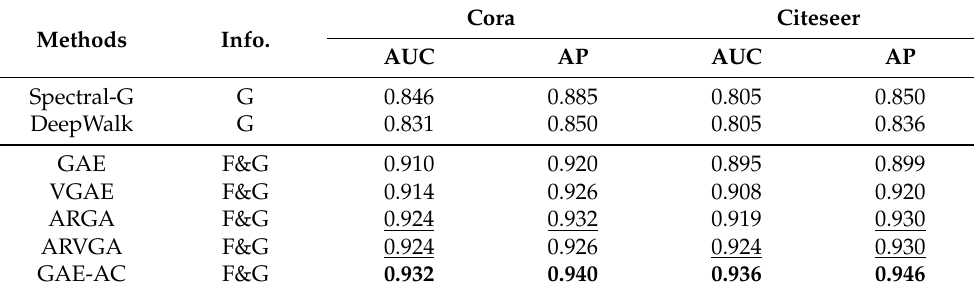
Table 5. Link Prediction Result on Cora and Citeseer Dataset.